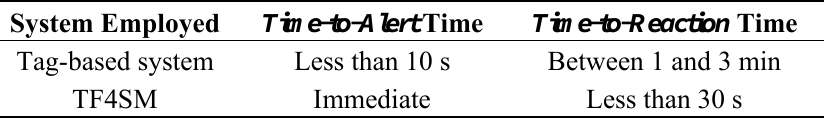
Table 5. Devices’